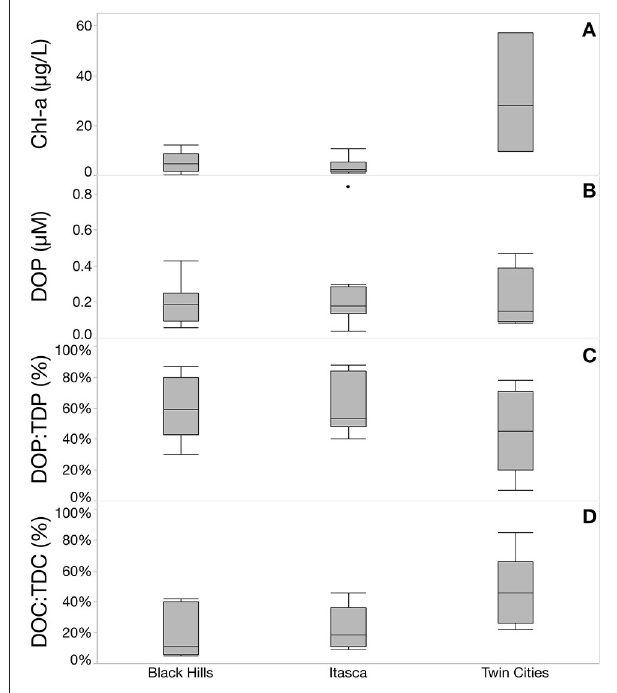
FIGURE 1 | Regional variability in measured lake characteristics. (A) Shows that chlorophyll concentrations were highest and most variable in the Twin Cities (urban) region. (B) Shows no significant differences in total DOP concentration across the three study regions and (C) shows no significant differences in the relative contribution of DOP to the total dissolved P pool, however the Twin Cities does show the largest range of relative DOP contribution. (D) Shows the contribution of DOC to the total dissolved carbon pool with the Twin Cities showing a much higher contribution of DOC compared to the other two regions, in other words, inorganic carbon dominates the dissolved carbon pool in the Black Hills and Itasca